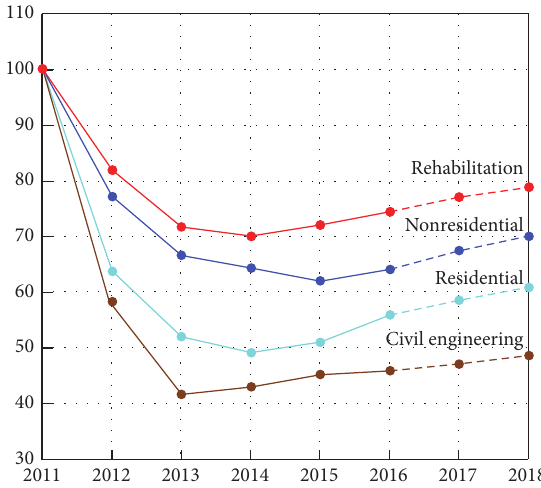
Figure 1: Evolution of the different subsectors in the Spanish building construction market. Production rates at constant prices, basis 2011 = 100.